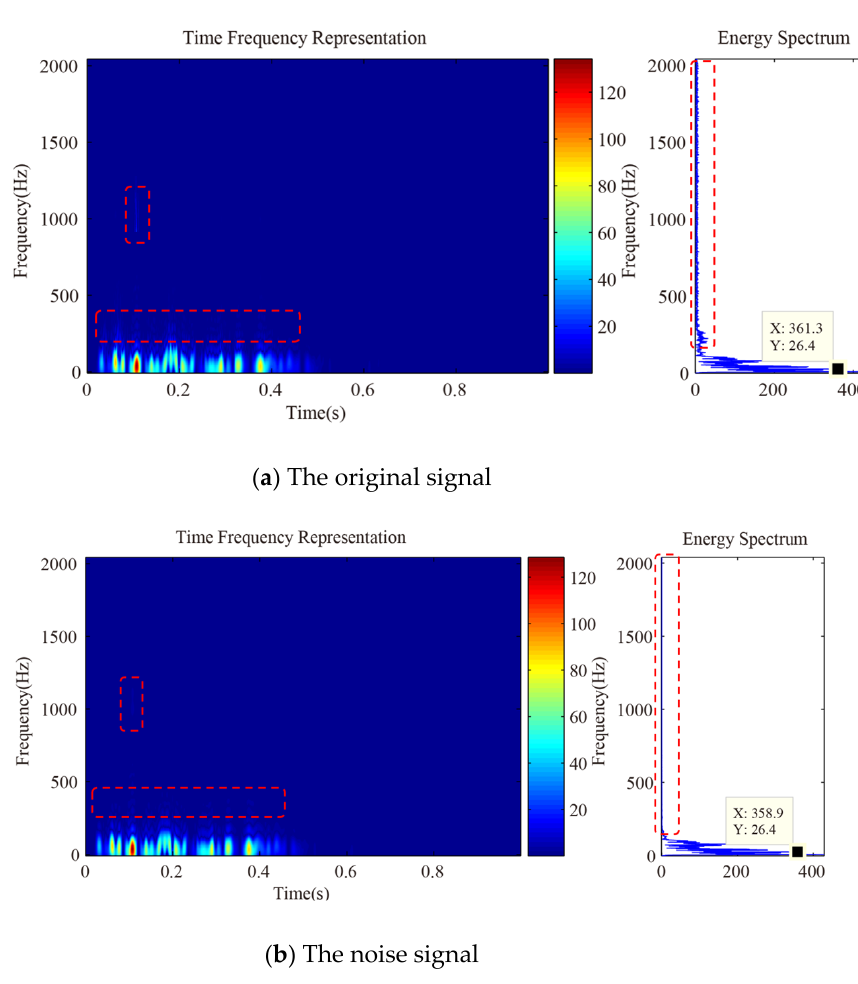
Figure 4. Blasting vibration signal after denoised.